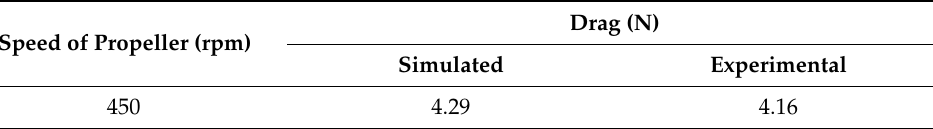
Table 17. Comparison between simulated and experimental drag.